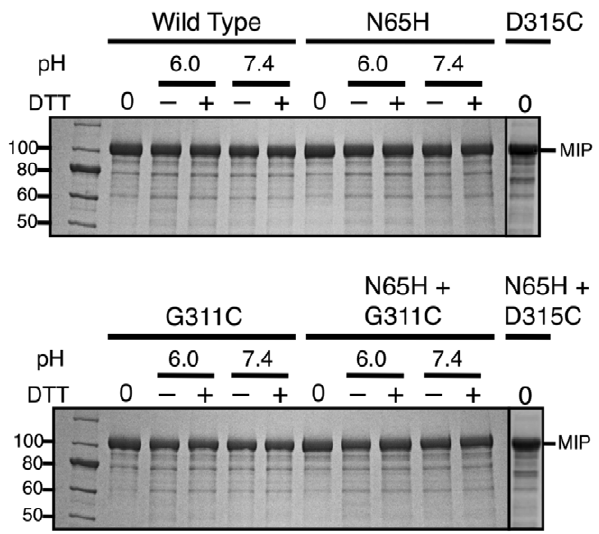
Figure 5. Mutations in the Arsp-FB24 Arth_1007 intein fail to restore activity. Only unspliced MIP precursor (109 kDa) was observed with the wild type intein or with inteins mutated at essential intein residues that restored the consensus amino acid at position B:10 (Asn 65 ) or possible F:4 positions (Asp 315 or Gly 311 ). Simply Blue Safe stained SDS-PAGE of soluble lysates after in vivo expression at 37 u C (0) or after incubation in vitro at 37 u C at the indicated pH values in the presence ( + ) or absence ( 2 ) of 50 mM DTT. Western Blots with anti-P sera failed to detect spliced MP or cleavage products in all samples (data not shown). Molecular weight standards are in the left lane of each gel and selected sizes are listed in kDa (New England Biolabs 10 to 250 kDa